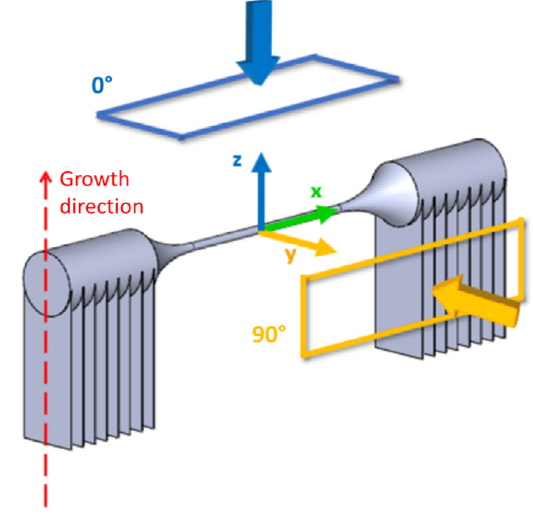
Figure 6. Reference direction for image acquisition.